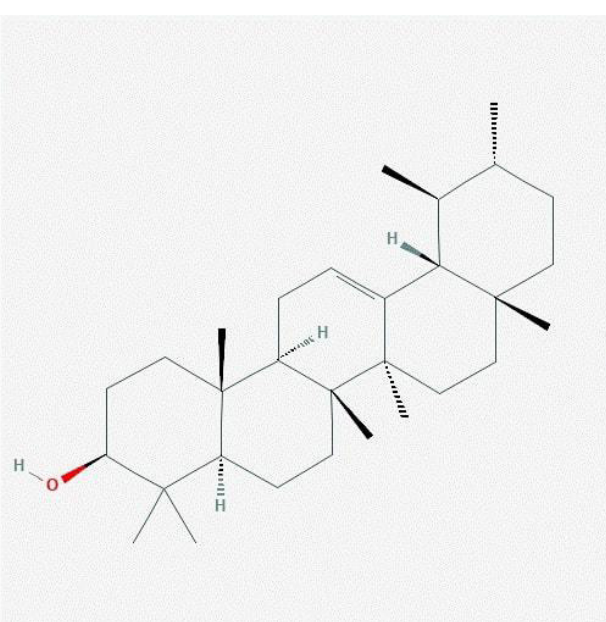
FIGURE 1A - Alpha-amyrin is a pentacyclic triterpenoid that is ursane which contains a double bond between positions 12 and 13 and in which the hydrogen at the 3beta position is substituted by a hydroxy group. It is a pentacyclic triterpenoid and a secondary alcohol. It derives from a hydride of an ursane.